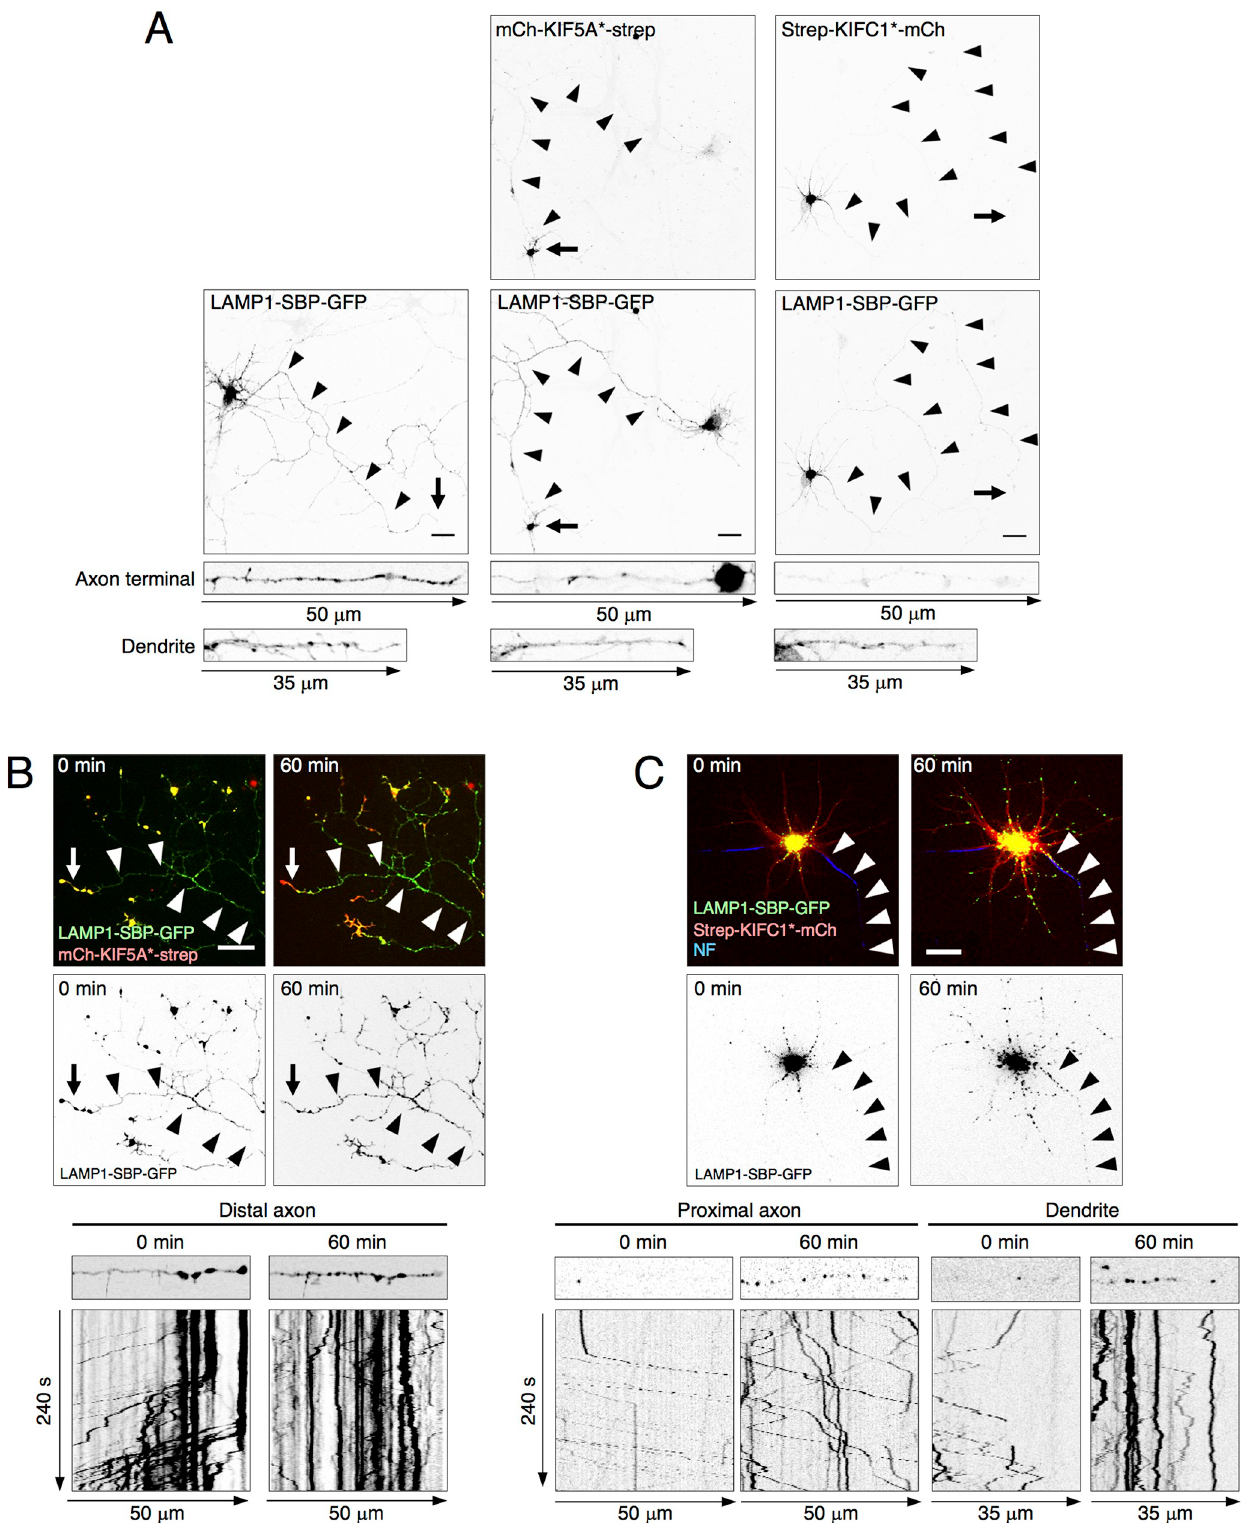
Fig 4. Analysis of polarized transport of neuronal lysosomes using RAMP. (A) DIV5 rat hippocampal neurons were transfected with plasmids encoding LAMP1-SBP-GFP alone (first column) or together with plasmids encoding mCh-KIF5A � -strep (second column) or strep-KIFC1 � -mCh (third column).